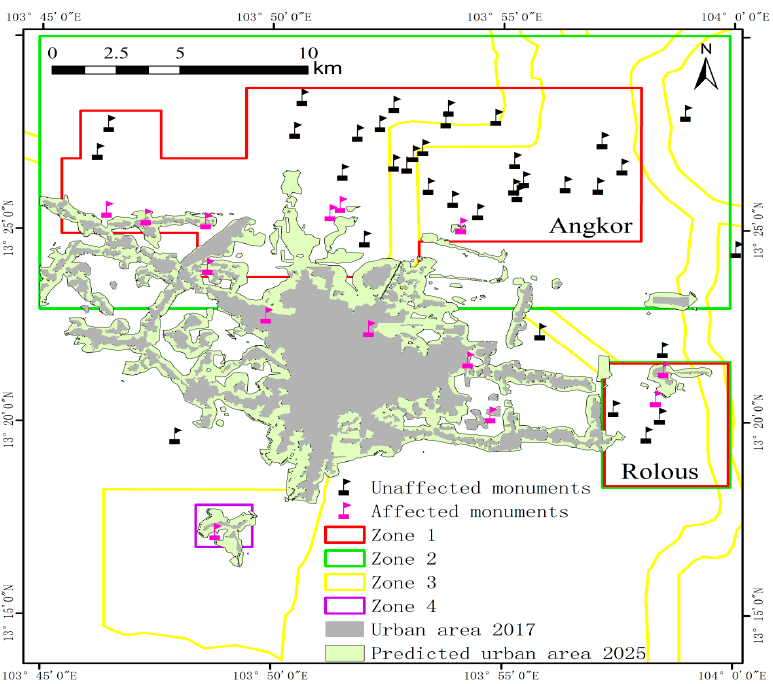
Figure 14. Predicted built-up area in protected area in 2025.